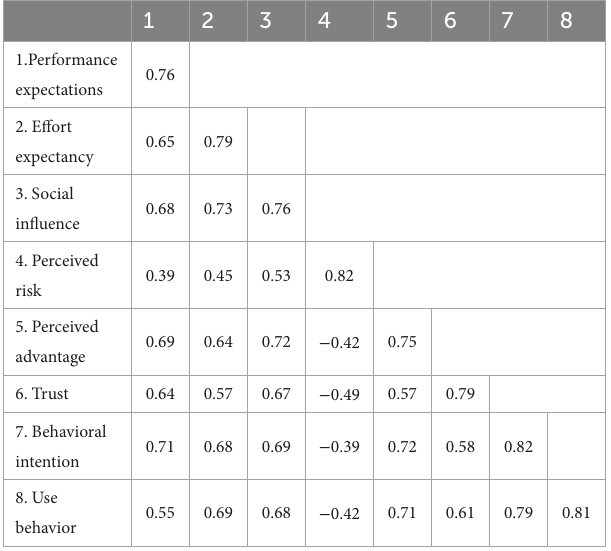
TABLE 2 AVEs and correlation coefficients of